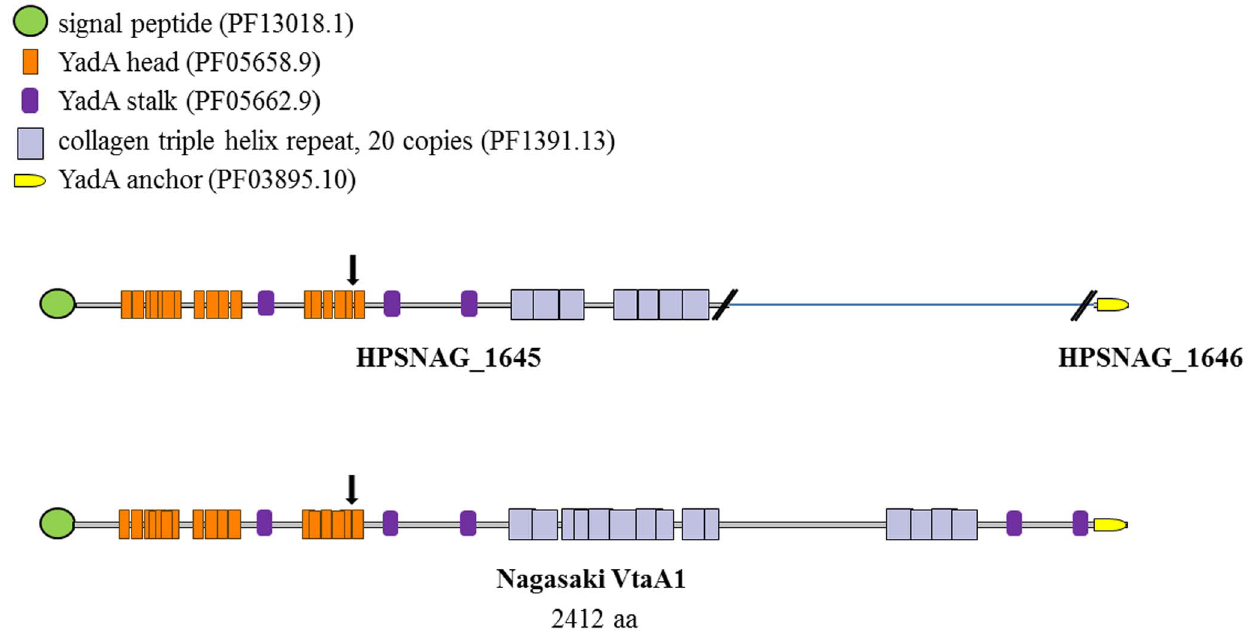
Figure 4. A comparison of the predicted protein structures of Nagasaki VtaA1 [20] and its highest scoring BLAST hit in the Nagasaki draft genome sequence, HPSNAG_1645. The CDS is interrupted by a break in the assembly within a region of collagen repeats. HPSNAG_1646 is a partial CDS encoding a group 1 YadA anchor domain, consistent with the group 1 anchor domain previously reported for Nagasaki VtaA1. Downward arrows indicate the location of DNA uptake signal sequences.